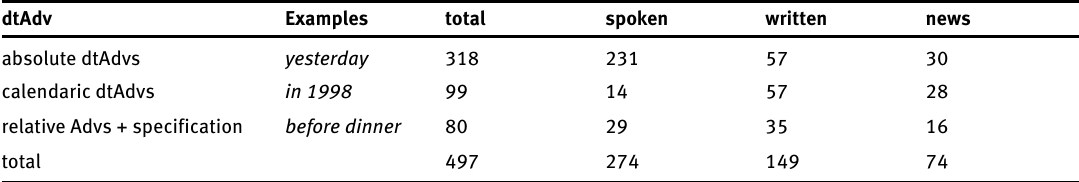
Table 2. Overview of database of non-prototypical Present Perfect constructions isolated from the COCA